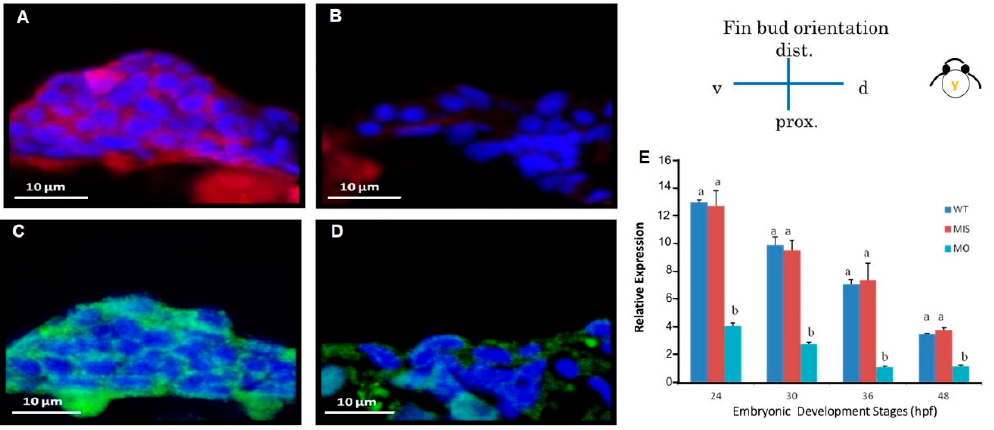
Figure 6. The immunochemical characterization of fibronectin and HA-binding protein in fin tissue at 48 hpf. Compared with wild-type embryos ( A , C ), tbx5a MO embryos showed decreased expression of fibronectin and HA-binding protein at 48 hpf ( B , D ). Cx43 expression in the tbx5a morphant group was significantly inhibited at 24, 30, 36, and 48 hpf ( n = 50, triplet) (E). a, b: A significant difference was detected by One-way ANOVA with Duncan’s multiple range test; red in ( A , B ), fibronectin; green in ( C , D ), HA-binding protein; blue: nuclear, WT: Uninjected group, MIS: Control MO-injected group, MO: tbx5a morphant group. 3.8. Increase in Apoptosis-Related Proteins in Pectoral Fins The terminal deoxynucleotidyl transferase dUTP nick end labeling (TUNEL) assay demonstrated only a few apoptotic cells in the Uninjected group at 37 hpf (Figure 2E,G,I). However, a marked increase in apoptotic cells was observed in the head, heart, fin, and spine in the tbx5a morphant group (Figure 2F,H,J). Two apoptosis-related proteins (B cell lymphoma 2 (BCL2) and BCL2-associated death promoter (BAD)) were examined by immunostaining at 30 hpf. Our results showed a remarkable increase in BCL2 and BAD protein expression in the tbx5a morphant group (Figure 7B,D) compared with that in the Uninjected group (Figure 7A,C). Using real-time RT-PCR, we confirmed that BAD (Figure 7E) and BCL2 (Figure 7F) were significantly upregulated in the tbx5a morphant group throughout the different stages of pectoral fin formation.